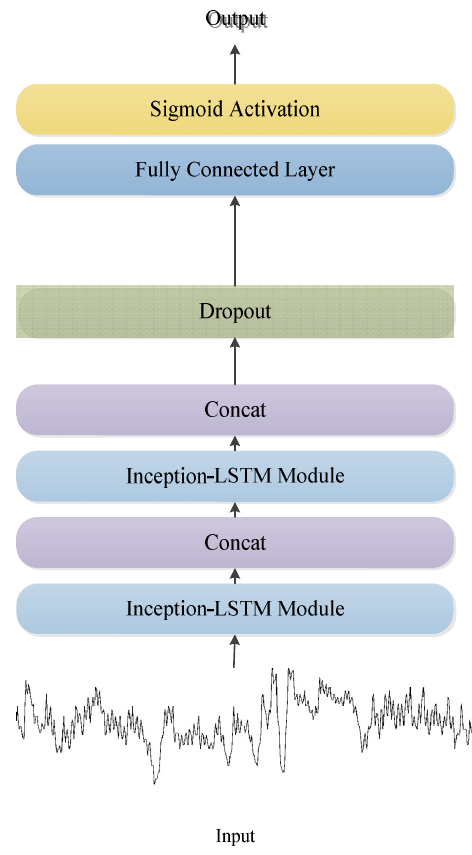
Figure 4. Network structure in this method, the input is RR intervals.